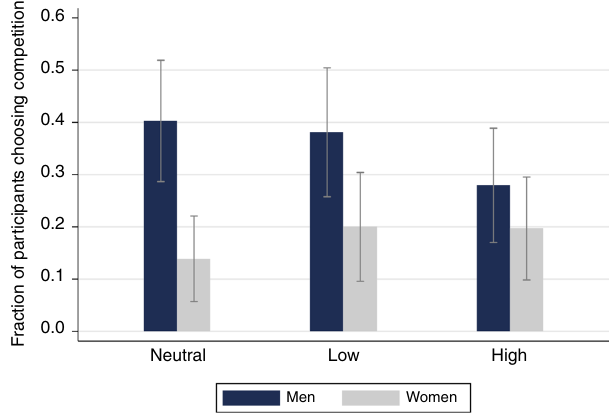
Fig. 2 Proportion of participants choosing competition in Stage 3 ( n = 401). The bars show, for each priming condition, the proportion of participants (between 0 and 1) who chose the tournament compensation rather than the piece rate. Error bars, mean ±